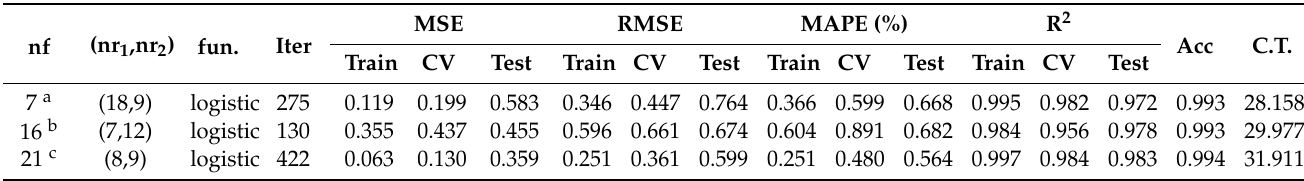
Table 7. Various architectures of BPNN model depending on the best-combined features extracted from visible and thermal imagery, with MSE, RMSE, MAPE (%), Acc, and R 2 in training, cross-validation, and test set. nf (nr 1 ,nr 2 )